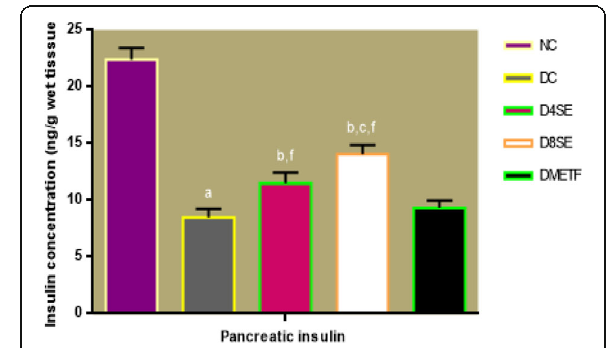
Fig. 6 Effect of SE and METF on serum and pancreatic insulin concentration in rats. Values are expressed as mean ± SEM of 8 rats. NC = Normal control, DC = Diabetic control, D4SE = Diabetic animals treated with SE (400 mg\kg BW), D8SE = Diabetic animals treated with SE (800 mg\kg BW), DMETF = Diabetic animals treated with metformin (12 mg\kg BW). a = significant when compared to NC, b = significant when compared to DC, c = significant when compared D4SE d = significant when compared to D8SE, f = significant when compared to